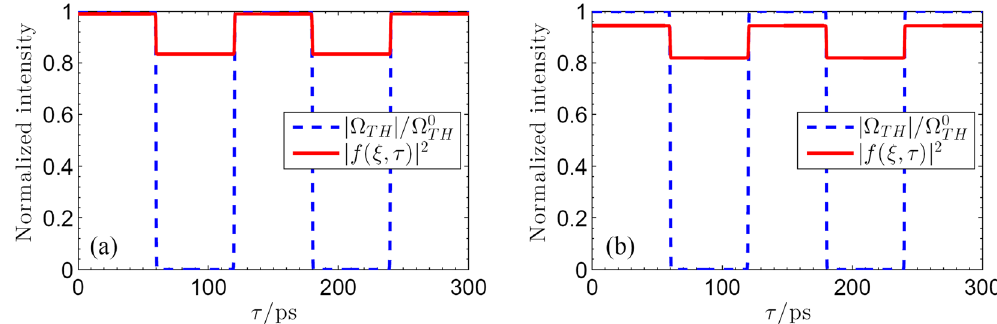
= γ = γ , γ = 3 × 10 13 s − 1 , γ = 0.05 γ , 31 32 21